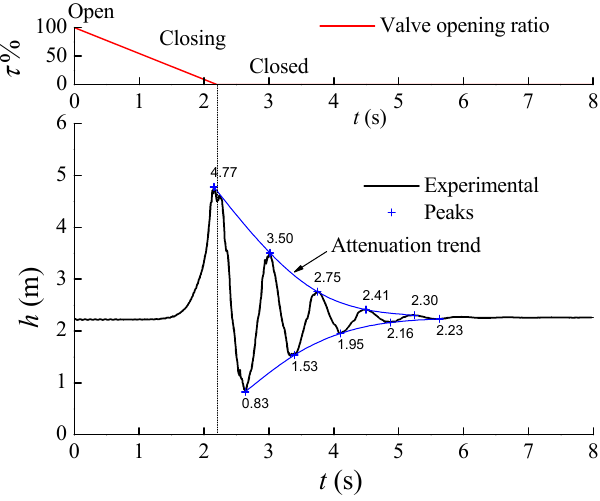
Figure 9. The positive and negative peaks in experimental measurement.